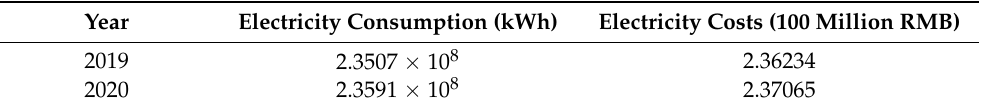
Figure 1. Peak-to-valley electricity price curve in the Beijing area. Table 1. Operators’ annual electricity consumption and electricity costs based on peak and valley electricity prices.